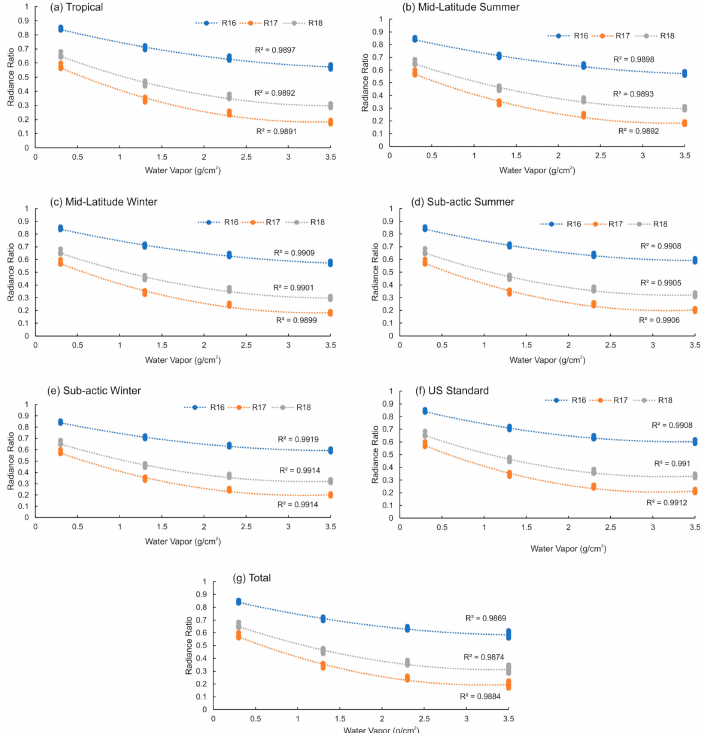
Figure 3. An example of simulated radiance obtained by MODTRAN 5, radiance ratios of two bands (absorption band / window band) as a function of PWV. ( a ) Tropical atmosphere, ( b ) mid-latitude summer, ( c ) mid-latitude winter, ( d ) sub-Arctic summer, ( e ) sub-Arctic winter, ( f ) U.S. standard, and ( g ) average of six